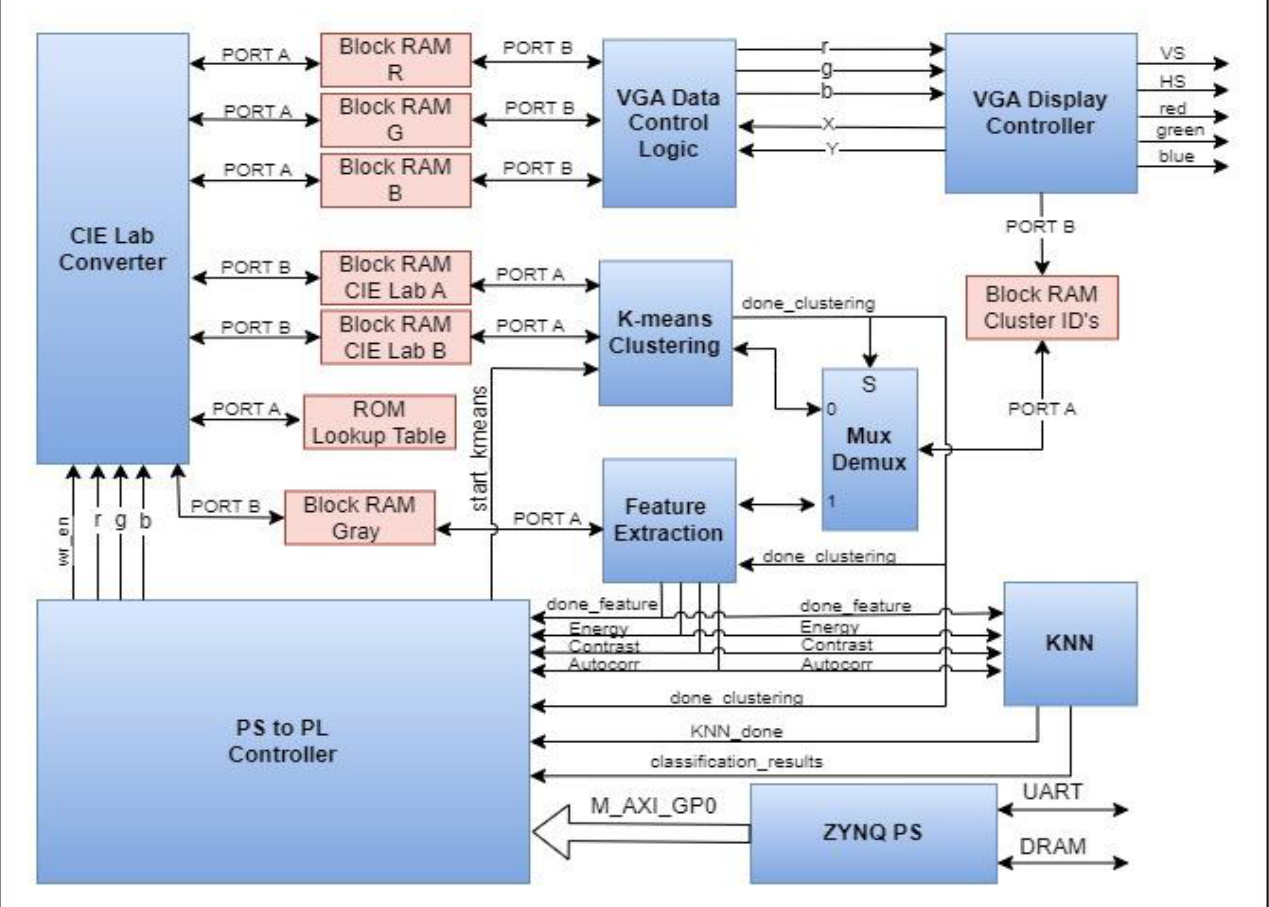
Fig. 5. Hardware architecture of proposed algorithm on